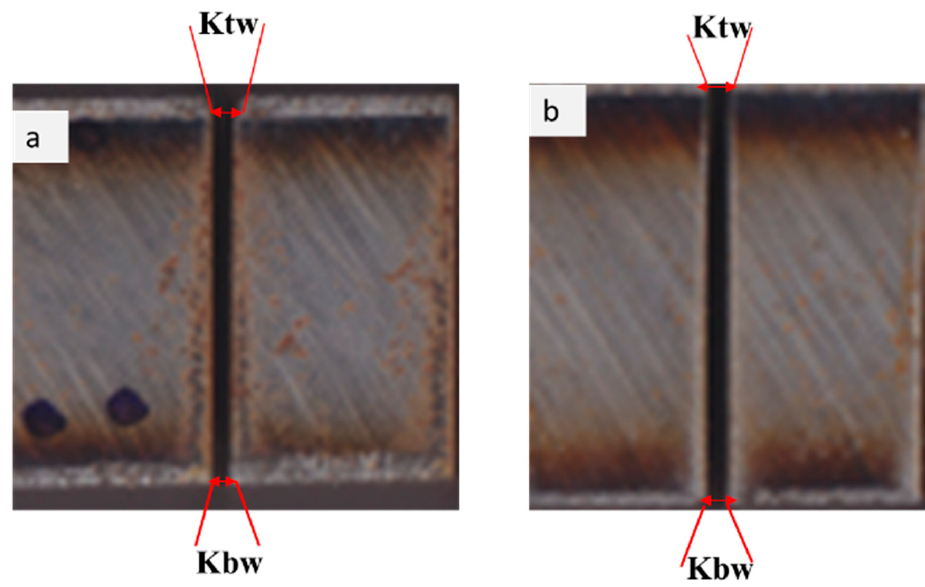
Figure 10. The kerf angle formation at different matching conditions: ( a ) SOD = 1 mm, JT = 10 mm/min, P = 220 MPa, and Ka = 0.651°, ( b ) SOD = 3 mm, JT = 5 mm/min, P = 240 MPa, and Ka = 0.804°.